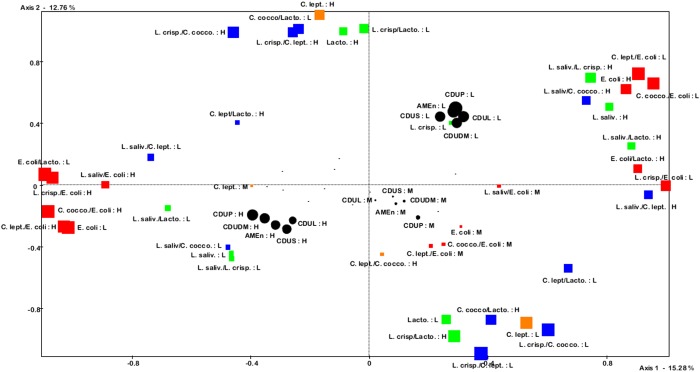
Multiple correspondence analysis of digestive microbiota in cecal contents and digestive efficiency traits.AMEn: metabolisable energy corrected to zero nitrogen retention; CDUDM, CDUL, CDUP, CDUS: coefficients of fecal digestive use of dry matter, lipids, proteins, and starch; Lacto.: Lactobacillus count; L. saliv.: L. salivarius count in cecal content; L. crisp.: L. crispatus count in cecal content; C. lept.: C. leptum count in cecal content; C. cocco.: C. coccoides count in cecal content; H, M, L: third of individuals with the highest, medium, and lowest values within a trait. The size of the squares is proportional to the relative contribution of the category of active variables to the axes. The size of the circles is proportional to the cos² between the axes and the category of the illustrative variable.